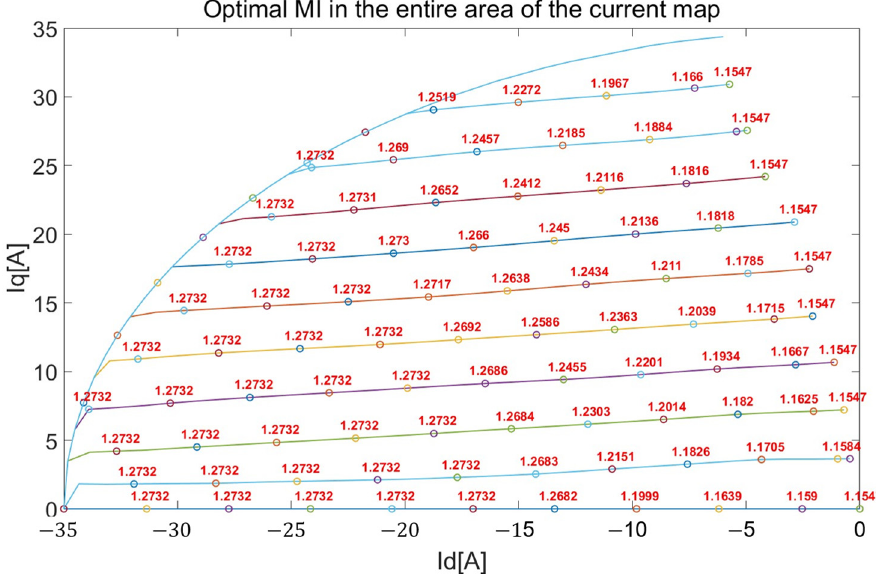
Figure 18. Optimal MI table matched to the current operating point.